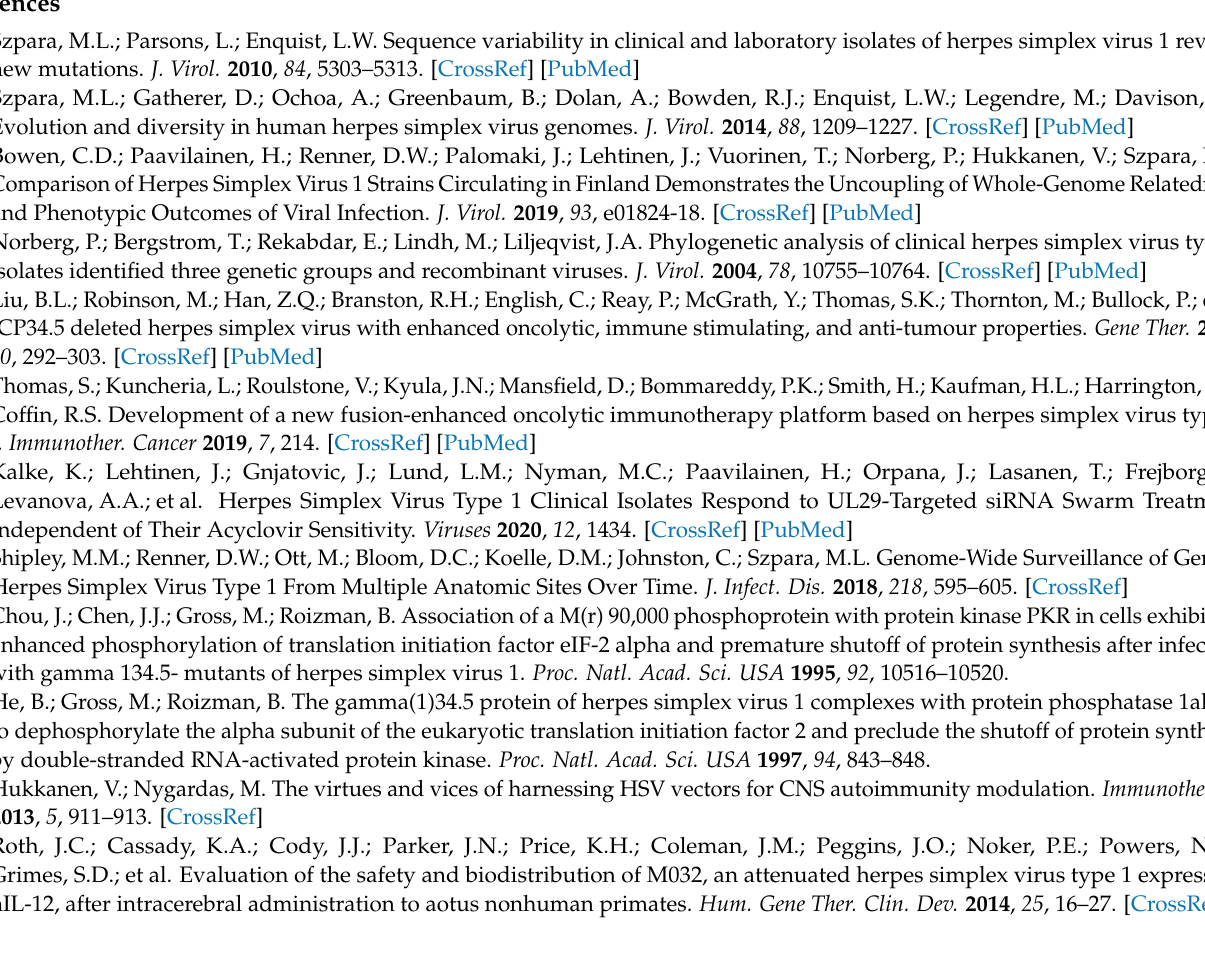
Table 1), File S1: UL27 alignment, File S2: US7